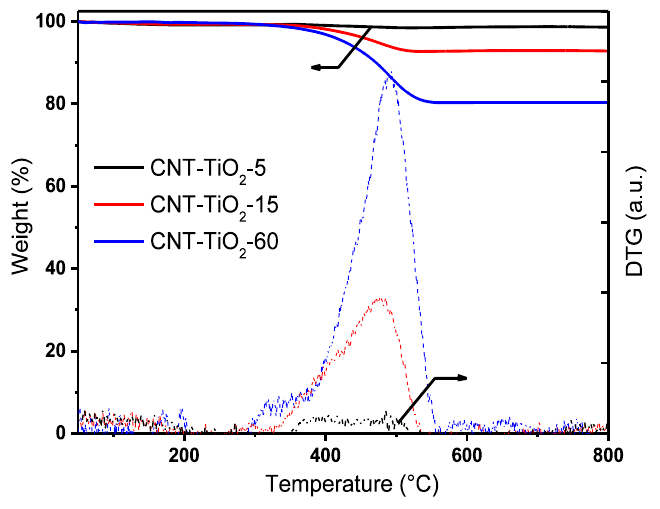
Figure 1. TG (solid lines) and DTG (dashed lines) curves for the CNT-TiO 2−δ composites. Black: CNT-TiO 2−δ -5 (5, five minutes); red: CNT-TiO 2−δ -15; blue: CNT-TiO 2−δ